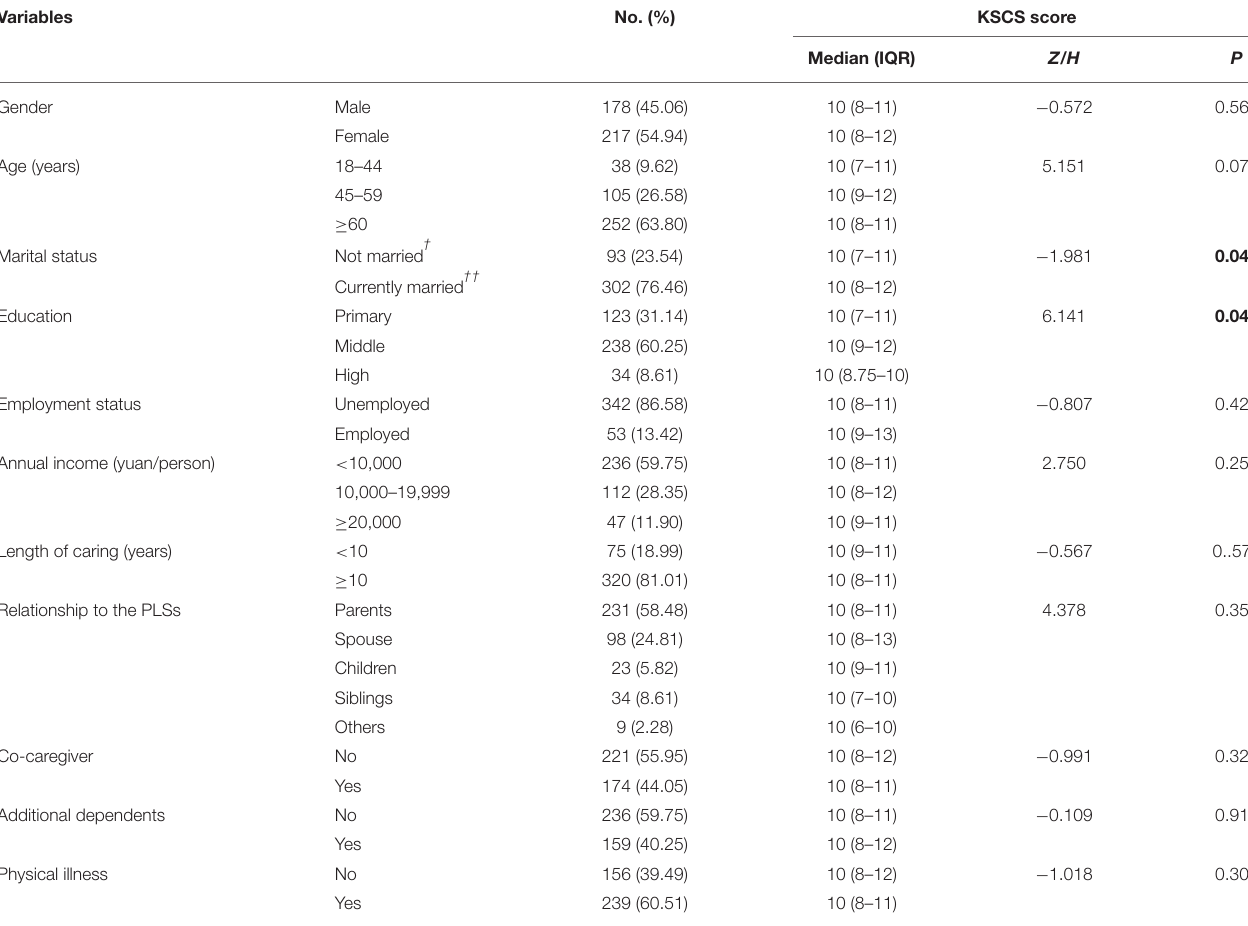
TABLE 1 | Sociodemographic characteristics of the caregivers and comparison of KSCS scores between groups.